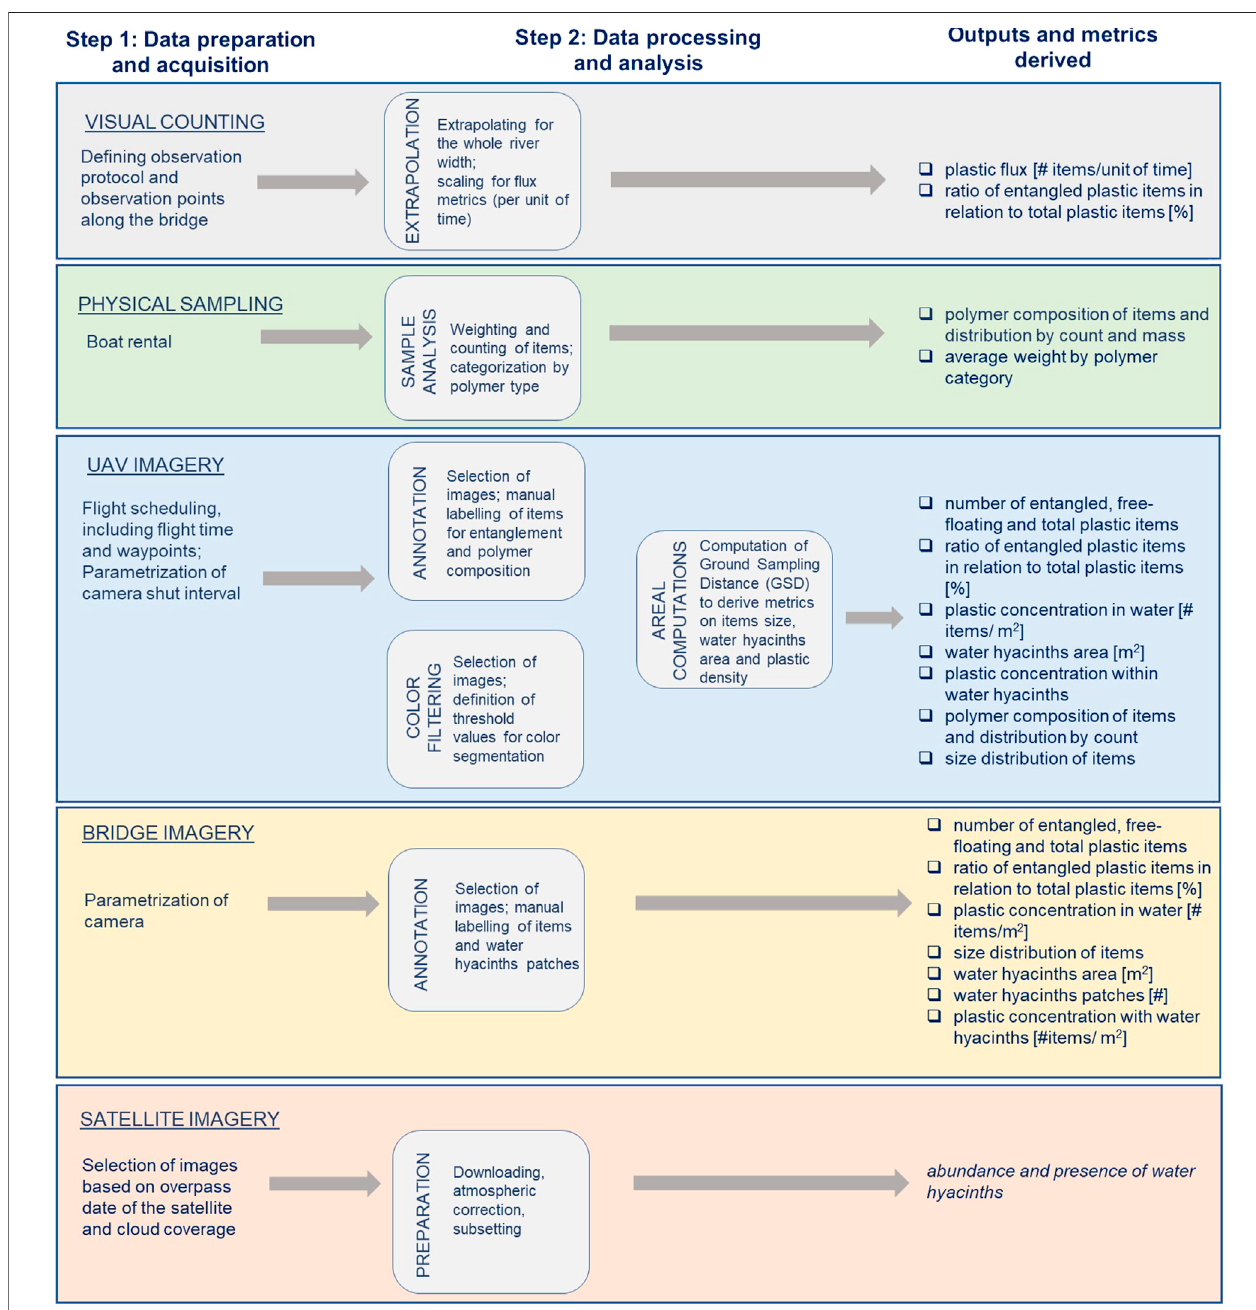
FIGURE 2 | Flowchart illustrating and summarizing steps required for deriving metrics on water hyacinths distribution, macroplastic transport, macroplastic entrapment in water hyacinths and plastic items characteristics.